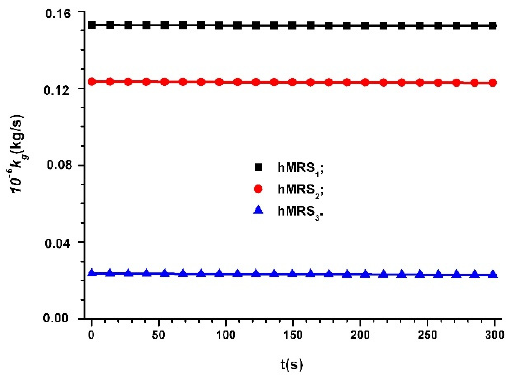
Figure 9. Time dependence of ℎ𝑀𝑅𝑆𝑠 coupling coefficient 𝑘 (cid:3034) in the absence of a magnetic field.